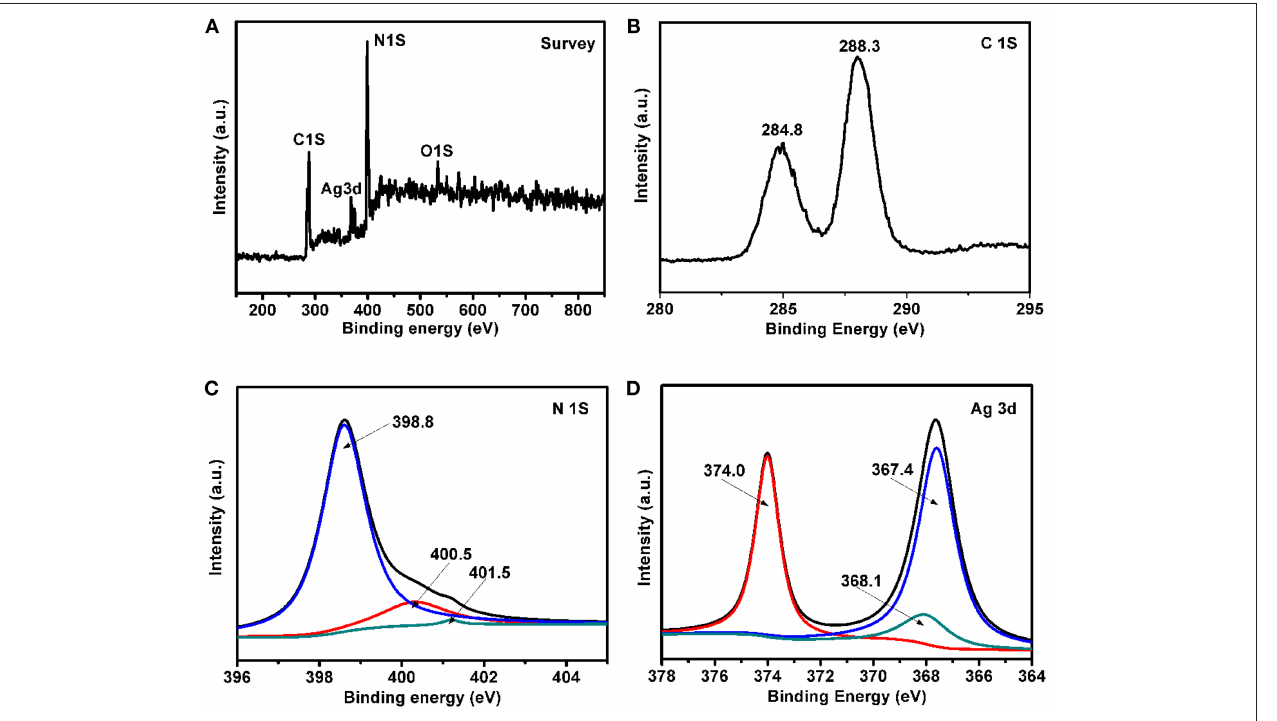
Frontiers in Chemistry |